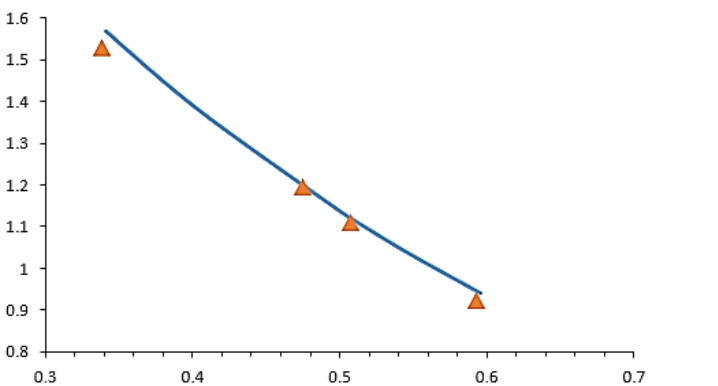
Figure 12. Relationship plot of strain to fracture and stress triaxiality: Flat specimens made of AISI1045 material. Table 7. Numerical failure parameters of AISI1045.